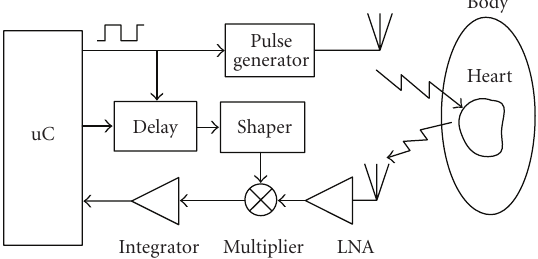
Figure 4: Block diagram of the proposed fully integrated UWB radar for the detection of heart and breath